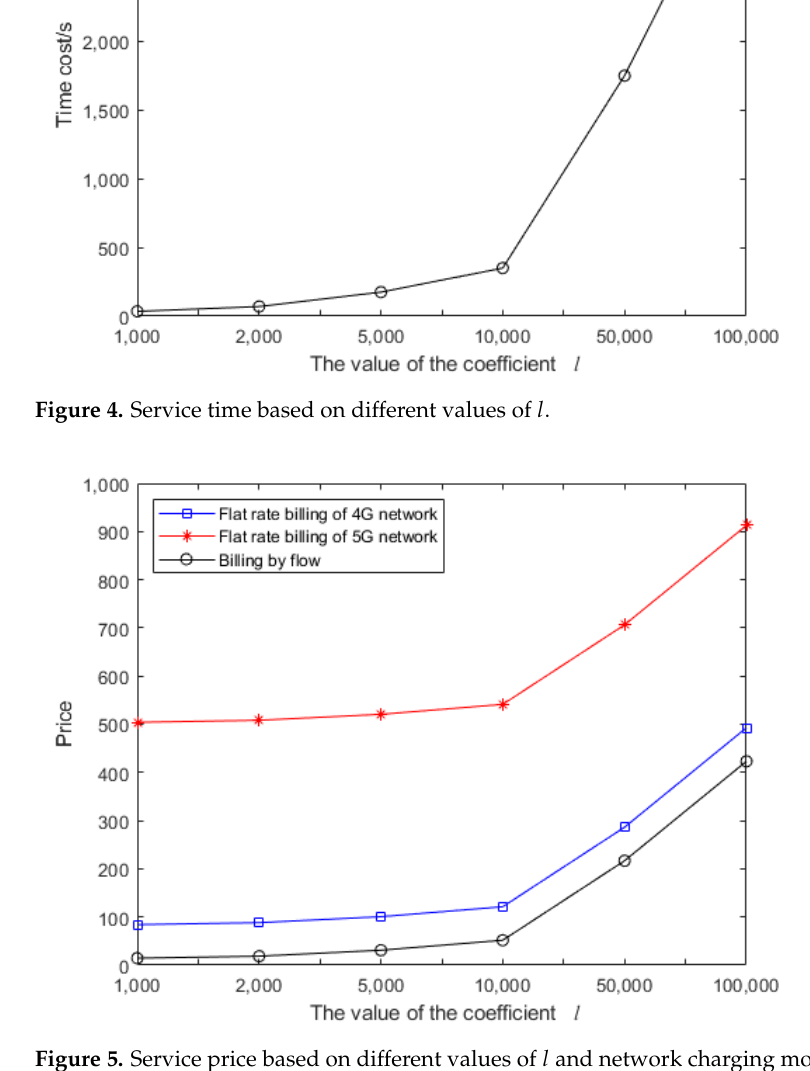
Figure 5. Service price based on different values of l and network charging